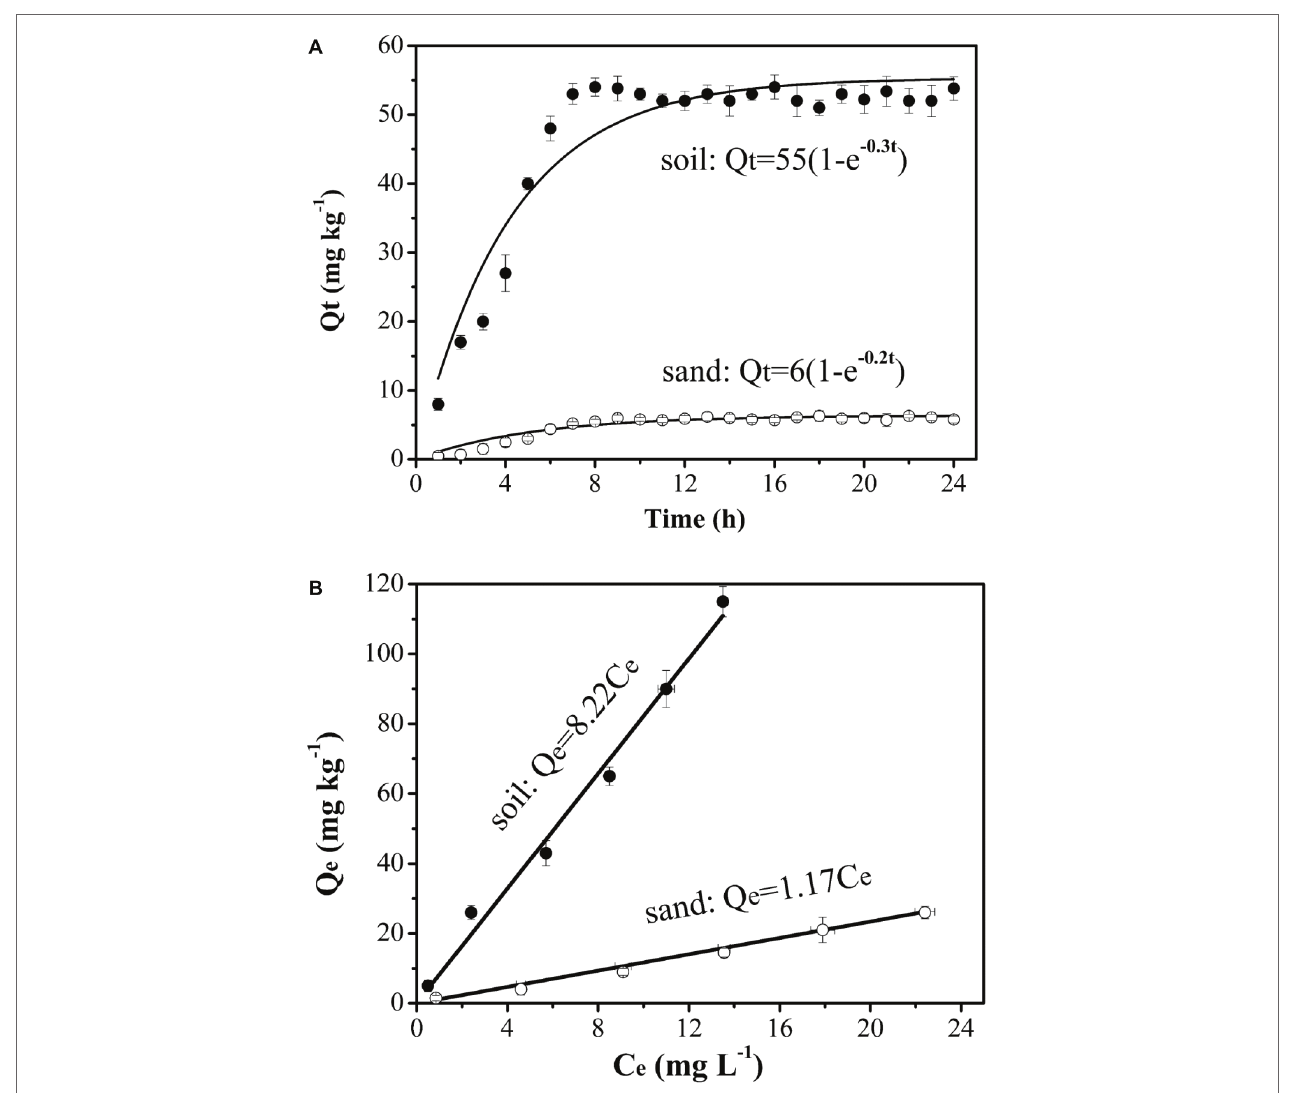
FIGURE 1 | Kinetics (A) and equilibrium (B) adsorption of naphthalene on sand and soil at 25°C. Error bars represent the standard deviation of two